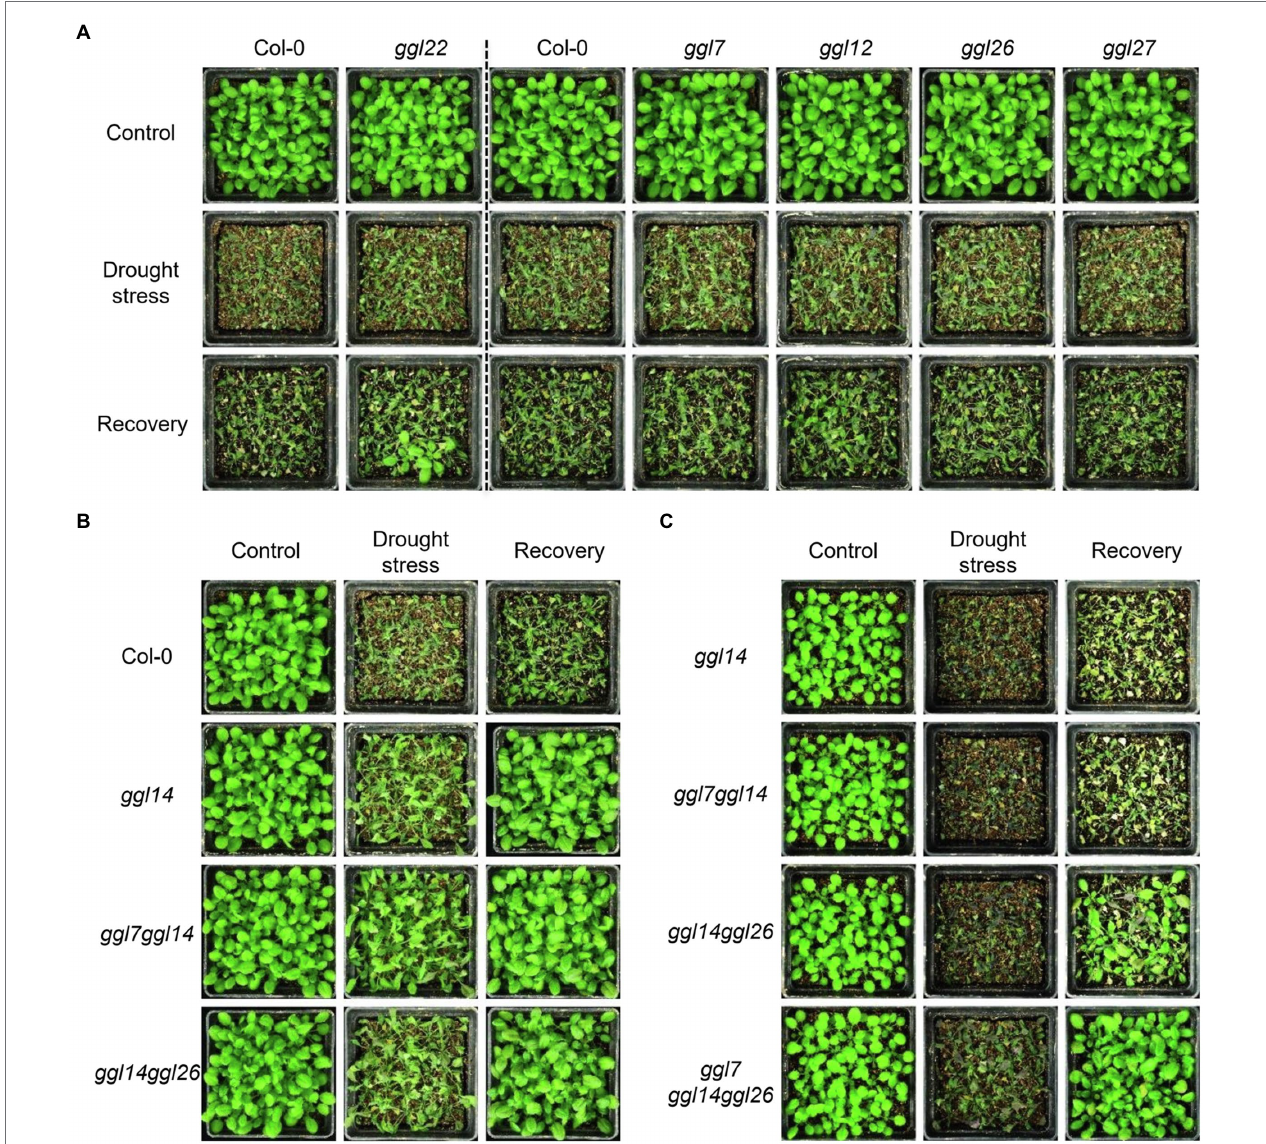
FIGURE 9 | GGL7 , GGL14 , and GGL26 show functional redundancy in plant drought performance. (A) Drought performance of ggl7 , ggl12 , ggl22 , ggl26 , and ggl27 single mutants under moderate drought stresses. (B) Drought performance of ggl14 , ggl7ggl14 , and ggl14ggl26 mutant plants under moderate drought stresses. (C) Drought performance of ggl14 , ggl7ggl14 , ggl14ggl26 , and ggl7ggl14ggl26 under severe drought stresses. Twenty-five plants per genotype were grown in the pots containing the same weight of soil and water content. For moderate drought stresses, plants were rewatered when ggl14 and WT plants showed significantly different wilting phenotypes. For severe drought stresses, plants were rewatered when significantly different wilting phenotypes were observed in ggl14 and ggl7ggl14ggl26 plants. The experiment was repeated two times with similar